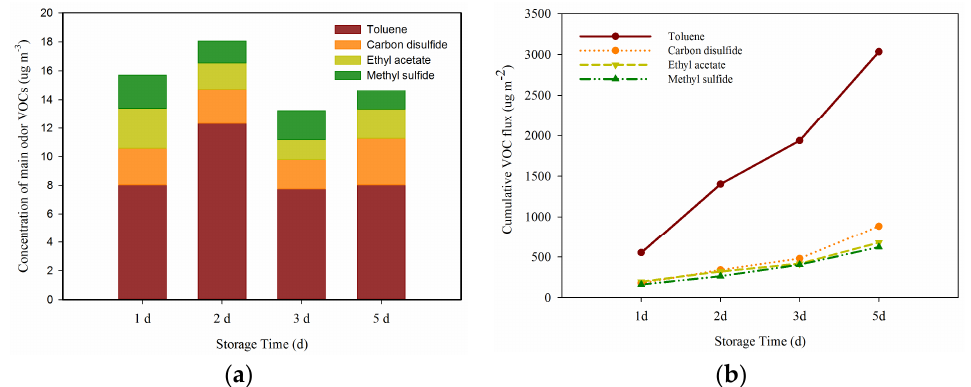
Figure 3. ( a ) Concentrations of main odorous VOCs during the biogas digestate (BD) storage; ( b ) cumulative fluxes of main odorous VOCs during the BDs.